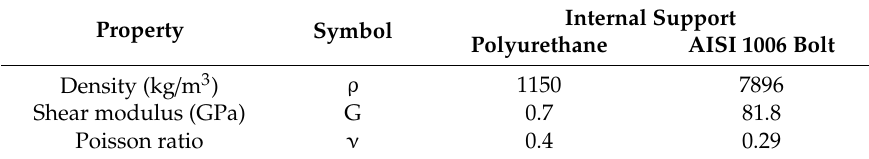
Table 3. Material properties of the polyurethane [24] and steel bolt [10].